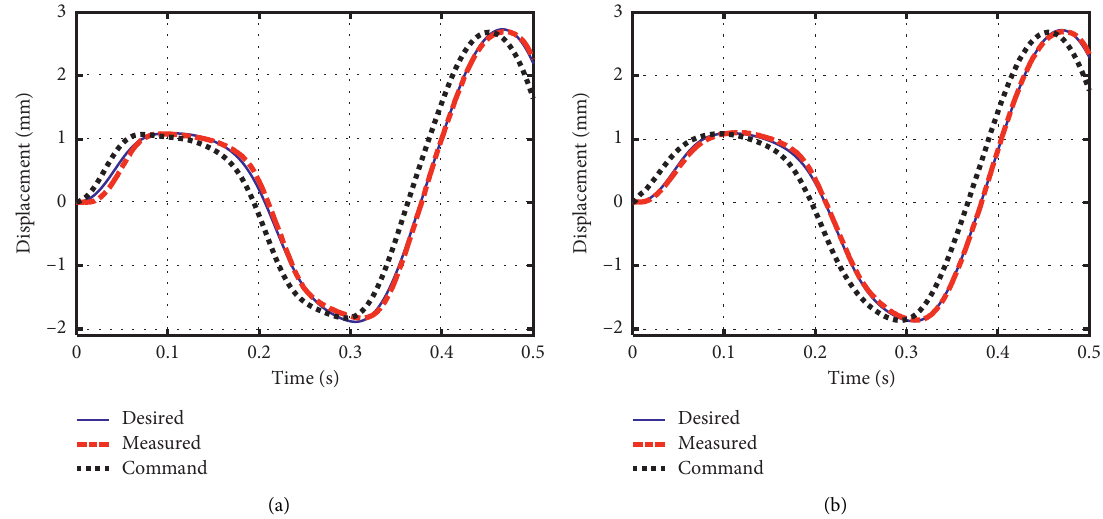
Figure 11: Time histories of displacements at the beginning of tests. (a) The SADC method. (b) The TADC method.